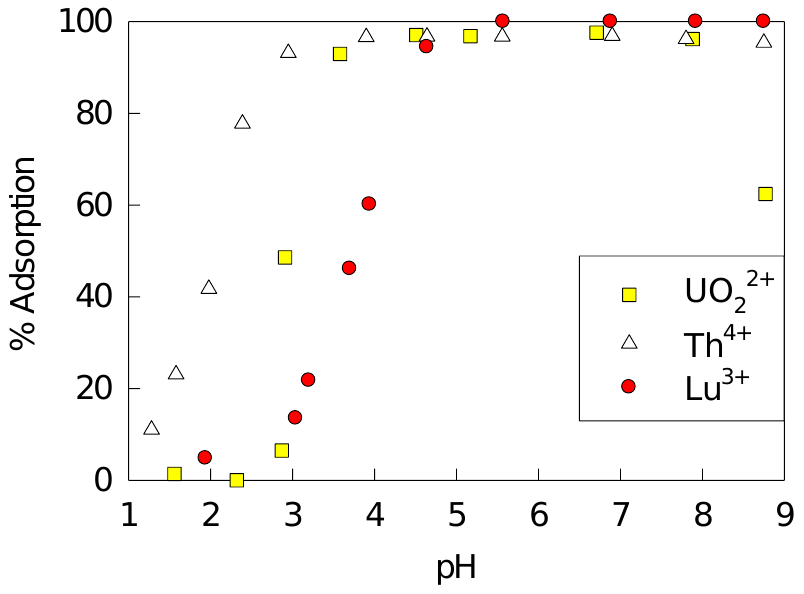
Figure 2. Percentage Adsorption of uranium(VI), thorium(IV) and lutetium(III) at varying equilibrium pH on PP gel [8] (with permission for reuse from